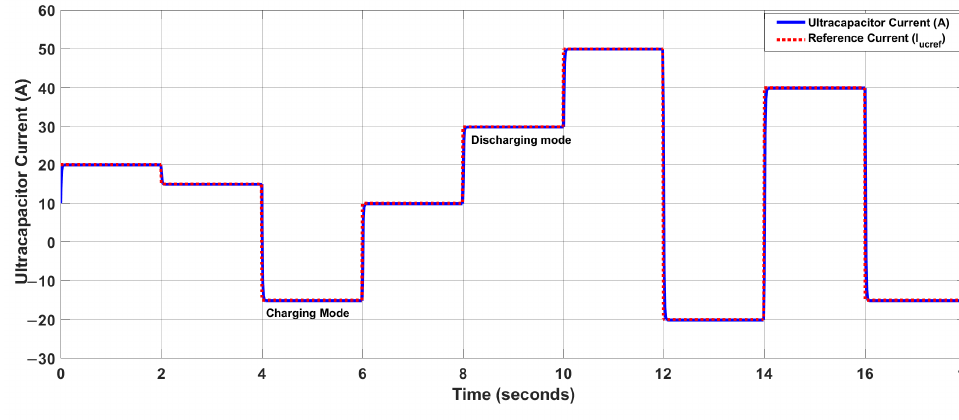
Figure 16. UC current x 4 (case-II).